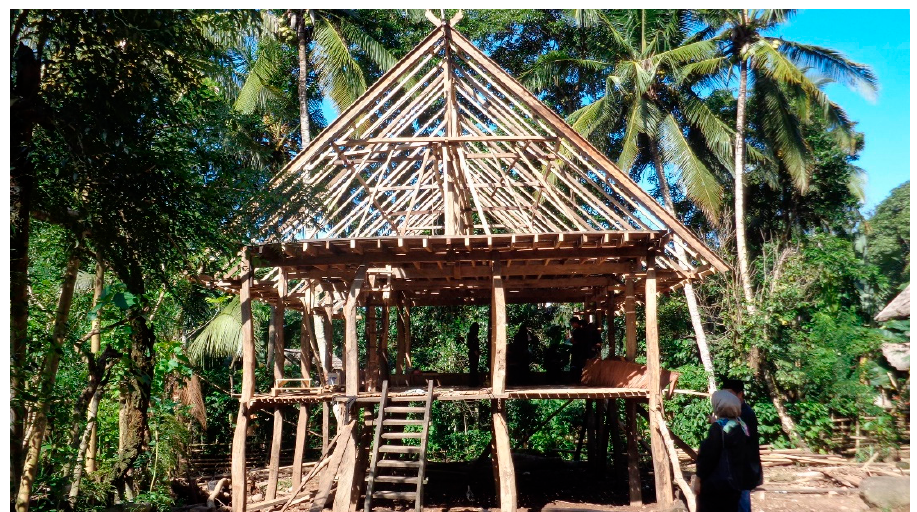
Figure 8. Frame of an Ammatoan house.